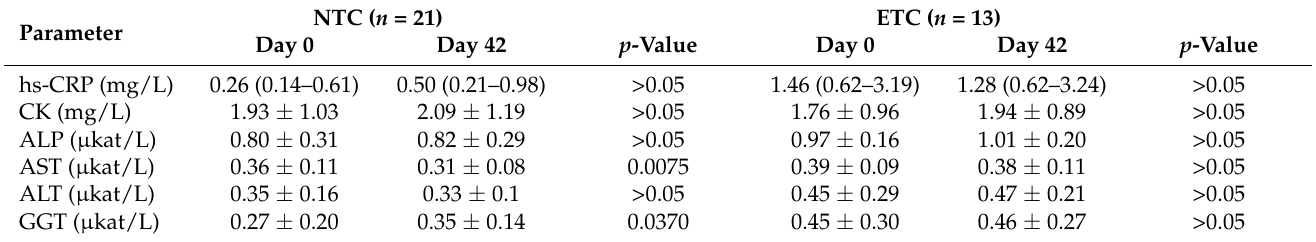
Table 6. High-sensitivity CRP, CK, and liver enzymes of the subjects before and after apricot seeds